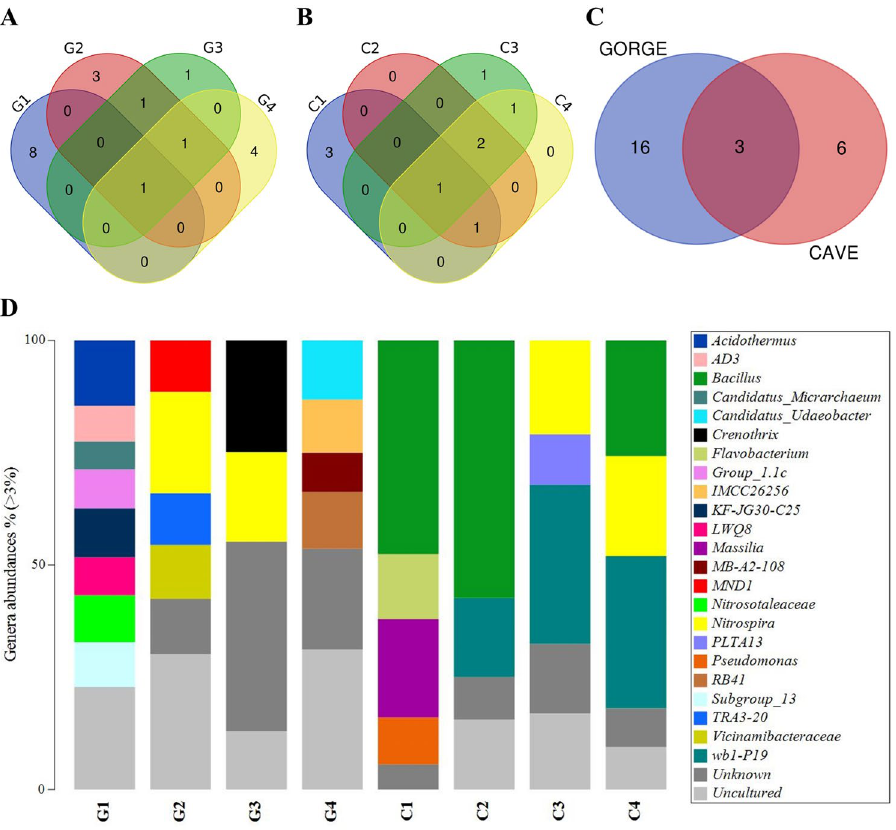
Figure 5. Venn diagrams and taxonomy barplot of ASVs at genus level. Venn diagrams show common genera found within gorge ( A ) and cave ( B ) samples and between the two groups (gorge vs cave). Taxonomy barplot shows the abundances (%) of main genera in each sample ( D ) (cutoff